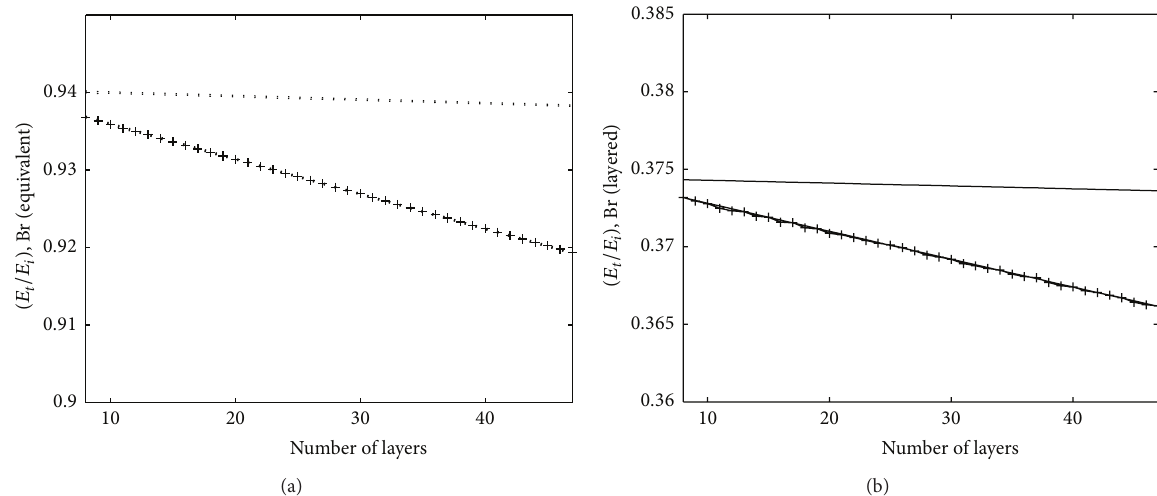
Figure 3: Effect of wave reflection when the concentration of one impurity varies randomly from layer to layer. All layers have the same thickness (20 cm—thinner lines—or 2 m—thicker lines marked by “+”). The continuous lines (b) mark the actual transmitted field and the dotted ones (a) mark the transmitted field in the “equivalent”